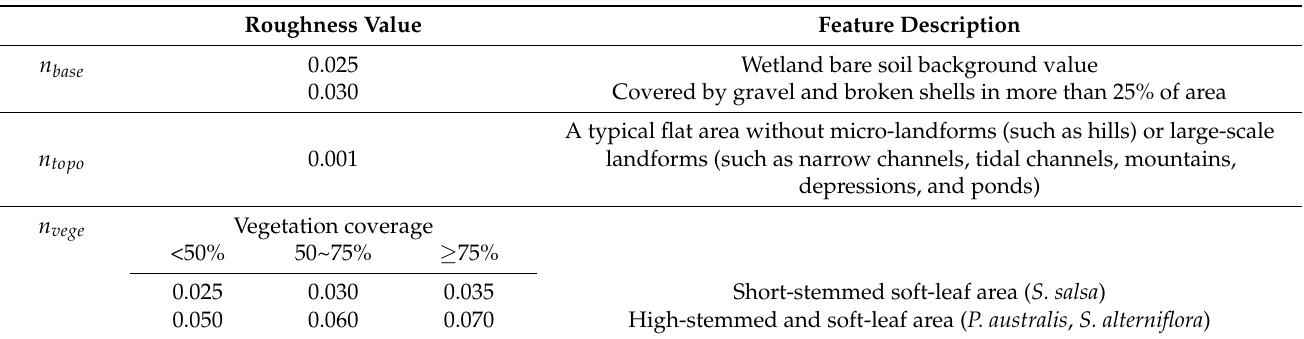
Table 2. Manning roughness coefficient index value.